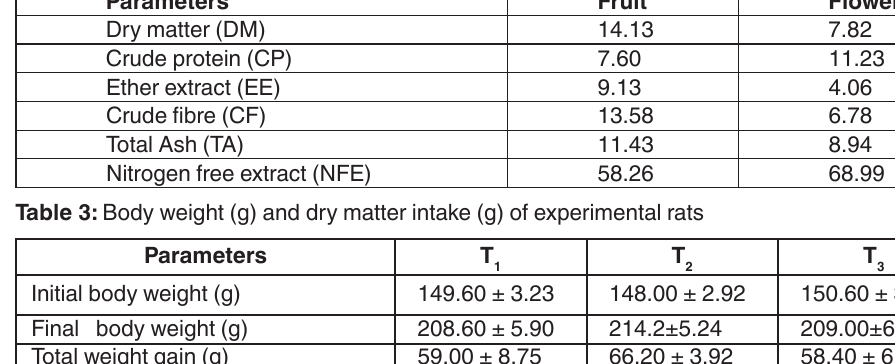
table 2. Chemical composition of Couroupita guianensis fruit and flower % (DM basis) Parameters